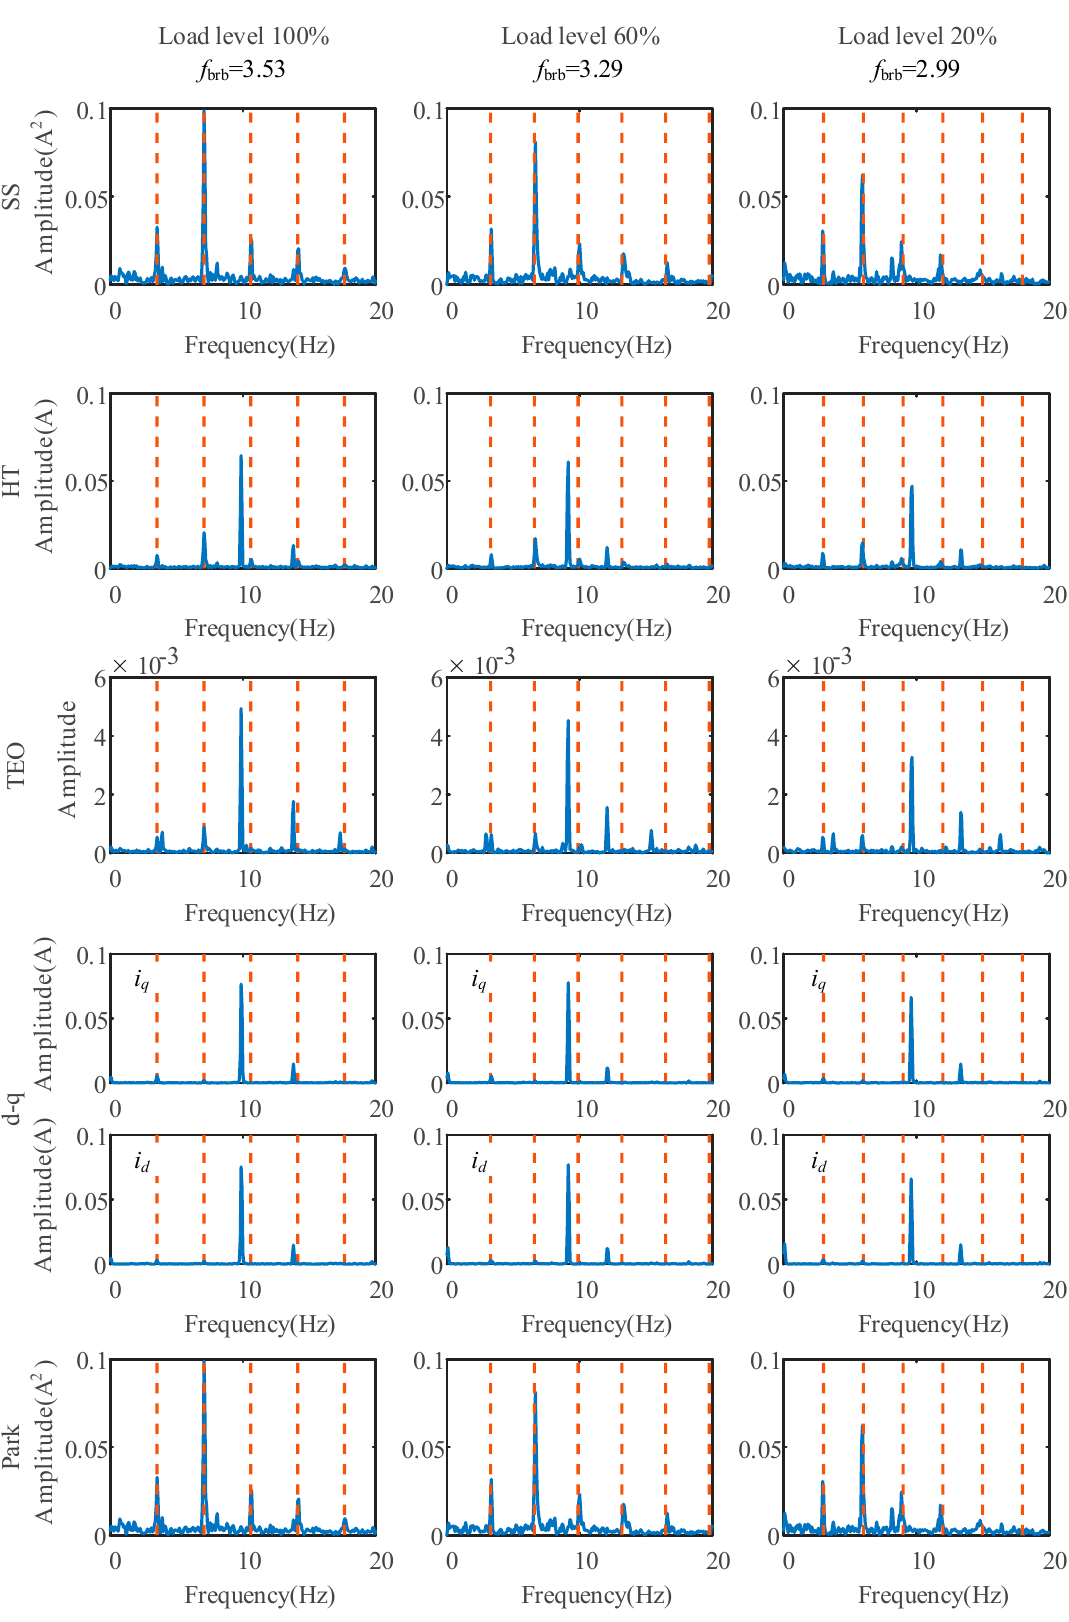
Figure 8. The spectra of data analysis using different algorithms.